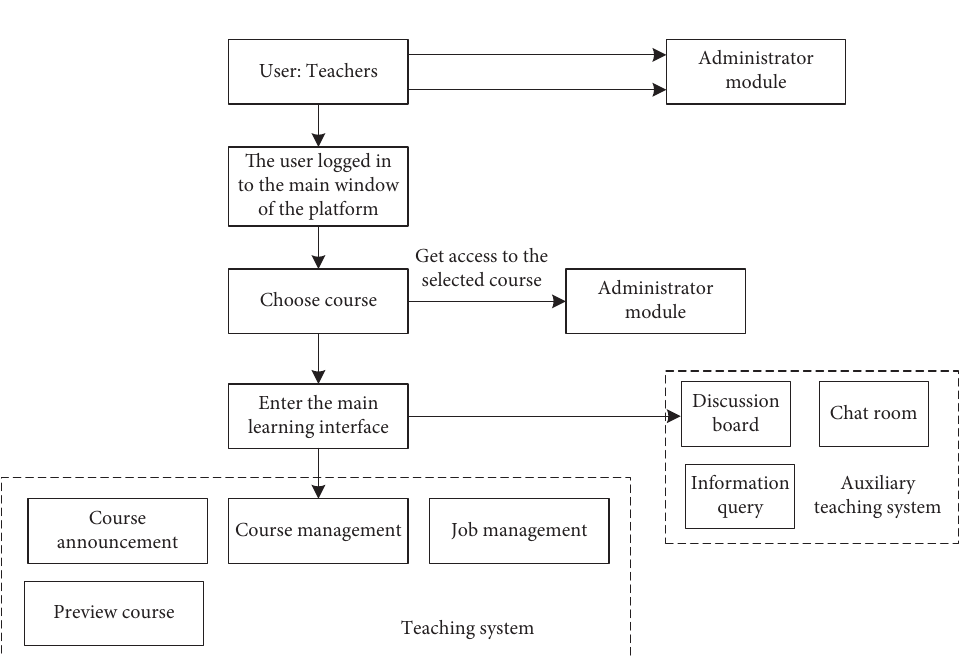
Figure 1: Workflow of student module.